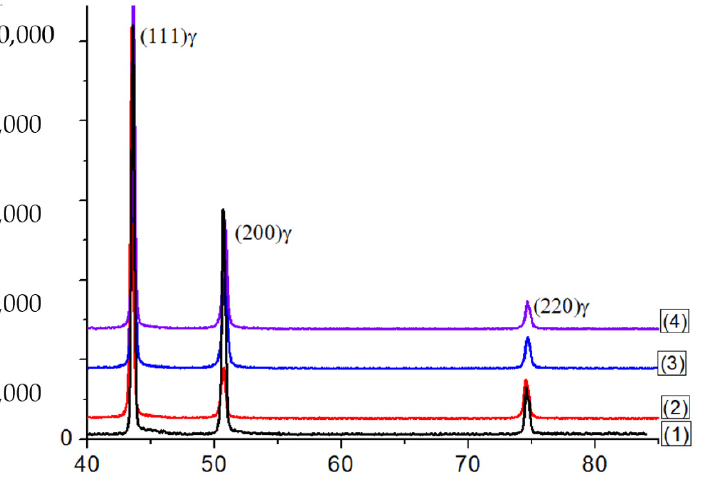
Figure 1. The X-ray diffractograms of the studied samples: (1) as-built; (2) 8 × 10 − 4 s − 1 ; (3) 3 × 10 − 3 s − 1 ; and (4) 2 × 10 − 2 s − 1 .